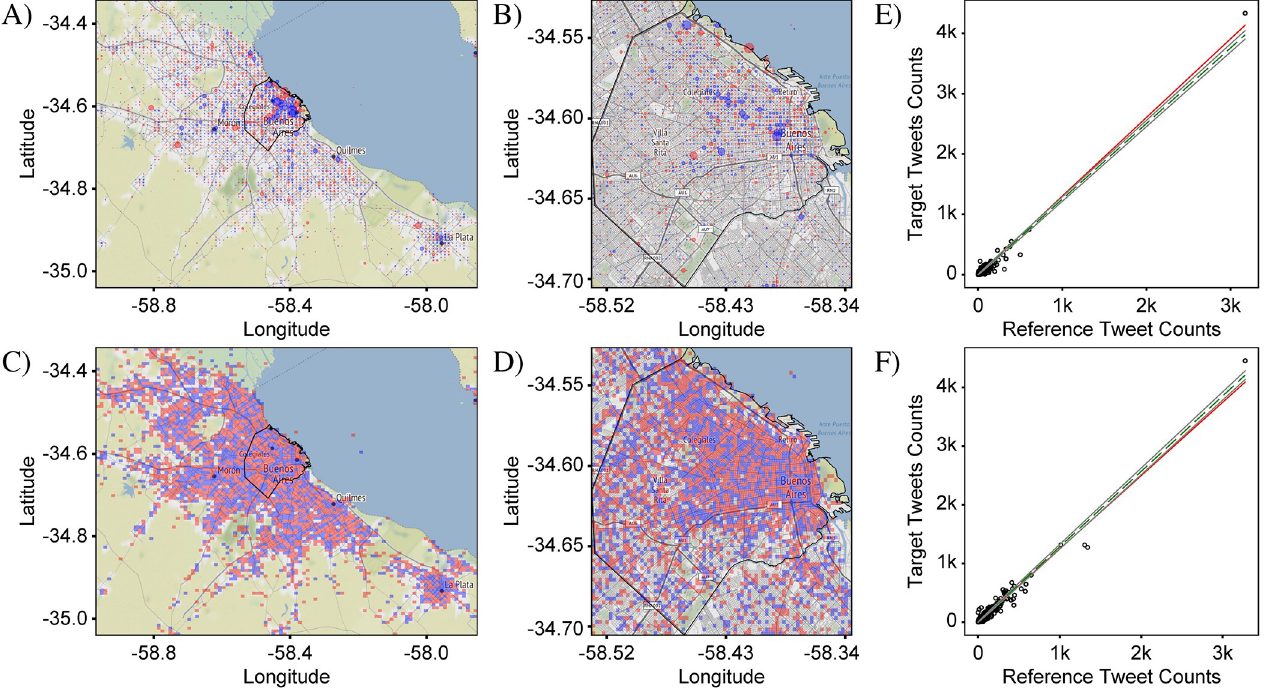
Fig 5. Null case “las” vs “los”. (A) & (B) are the differential distributions of plural determiners in Spanish “las” (feminine) vs. “los” (masculine) plotted over the extents of CABA+ and CABA, repectively, using the “circles” representation that highlights magnitudes of differences. Blue (red) shows where “los” (“las”) is more prominently used. (C) & (D) are the same as (A) & (B), except plotted using the “squares” representation which highlights spatial patterns. All four graphs show that “los” and “las” are just about equally represented across the city. (E) & (F) are the “frequency comparison plots” for CABA+ and CABA respectively, and show that counts of “las” correlate very well with counts of “los”, indicating the lack of a strong variation signal on either scale. CABA + Statistics: N T = 65,573, N R = 51,033, S PCC = 0.02, KSS = 0.02, GMI = 0.15. CABA Statistics: N T = 38,870, N R = 31,021, S PCC = 0.02, KSS = 0.02, GMI = 0.09. Base map and data from OpenStreetMap and OpenStreetMap Foundation under the Open Database License (Fig 5A–5D).